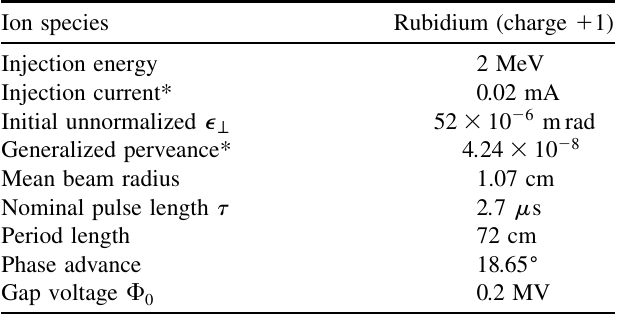
TABLE I. Beam and lattice parameters. (cid:2) ¼ 7 : 08 (cid:3) 10 (cid:1) 3 ; (cid:3) (cid:4) 1 ; * can be varied; see Refs. [4–6] for matched beam envelope calculations.